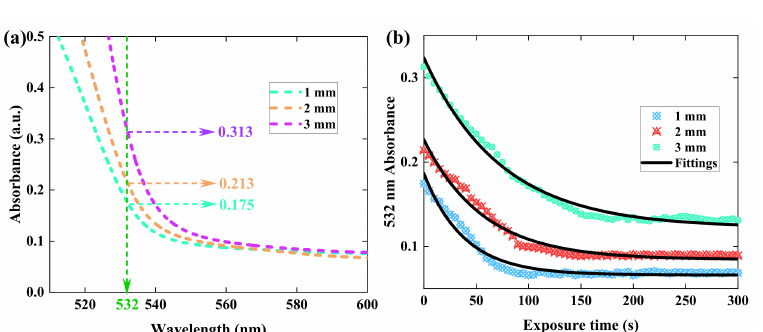
Figure 2. ( a ) The absorption spectrum of PQ/PMMA polymers with 1–3 mm thickness, ( b ) experi- mental results of absorbance variations in 1–3 mm thick PQ/PMMA